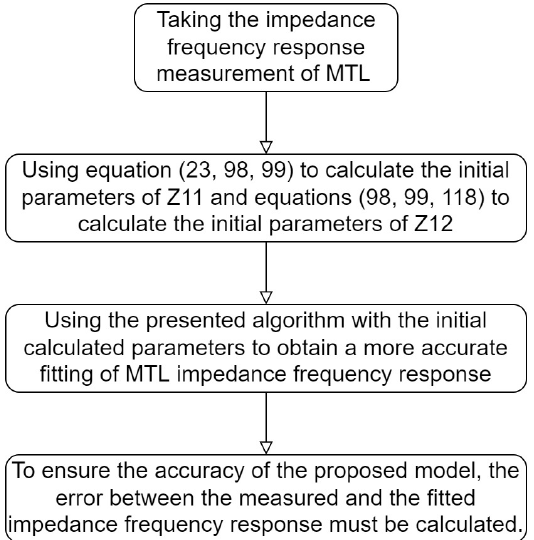
Figure 15. Implementation procedure of the proposed